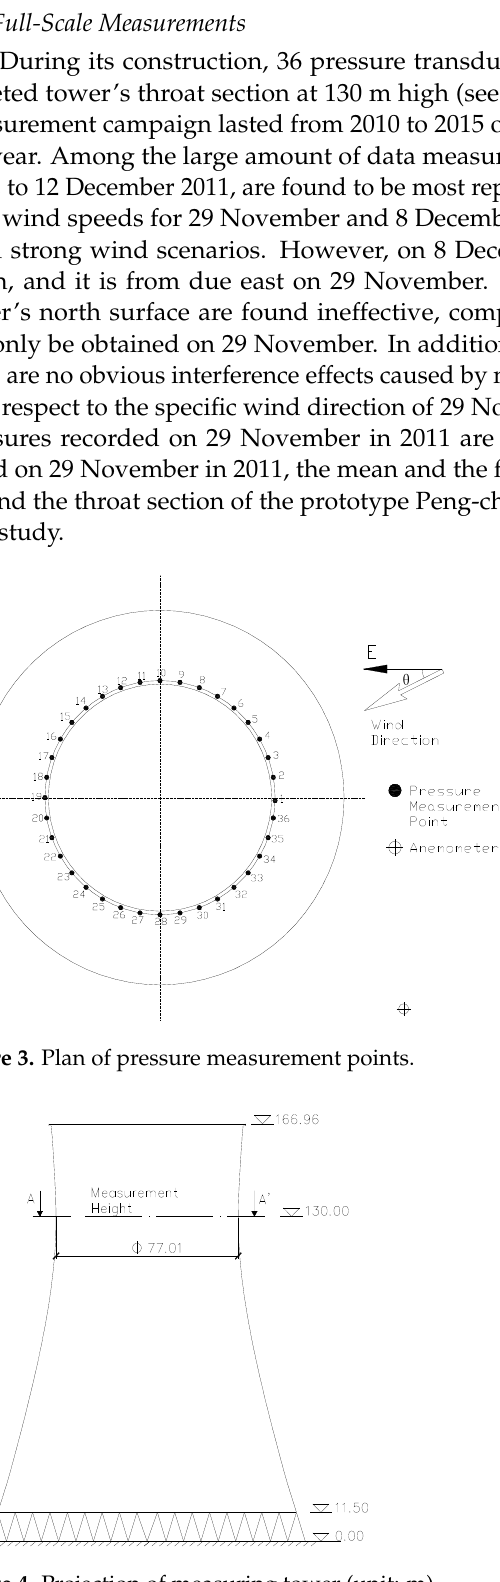
Figure 2. Site plan of Peng-cheng electric power station (unit: m).